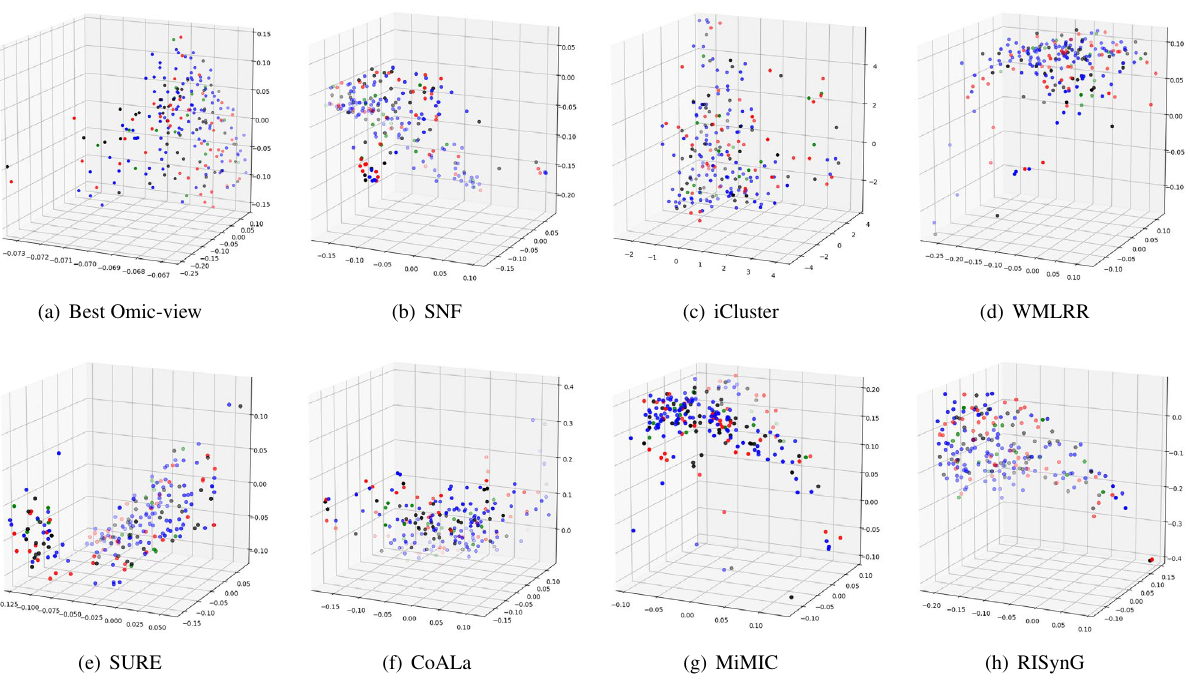
Figure 7. Comparative analysis of different integrative sub-spaces for STAD